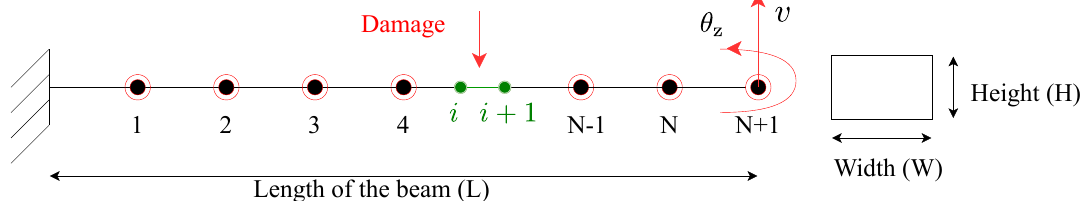
Figure 1. 2D FE model of a cantilever beam and cross-section